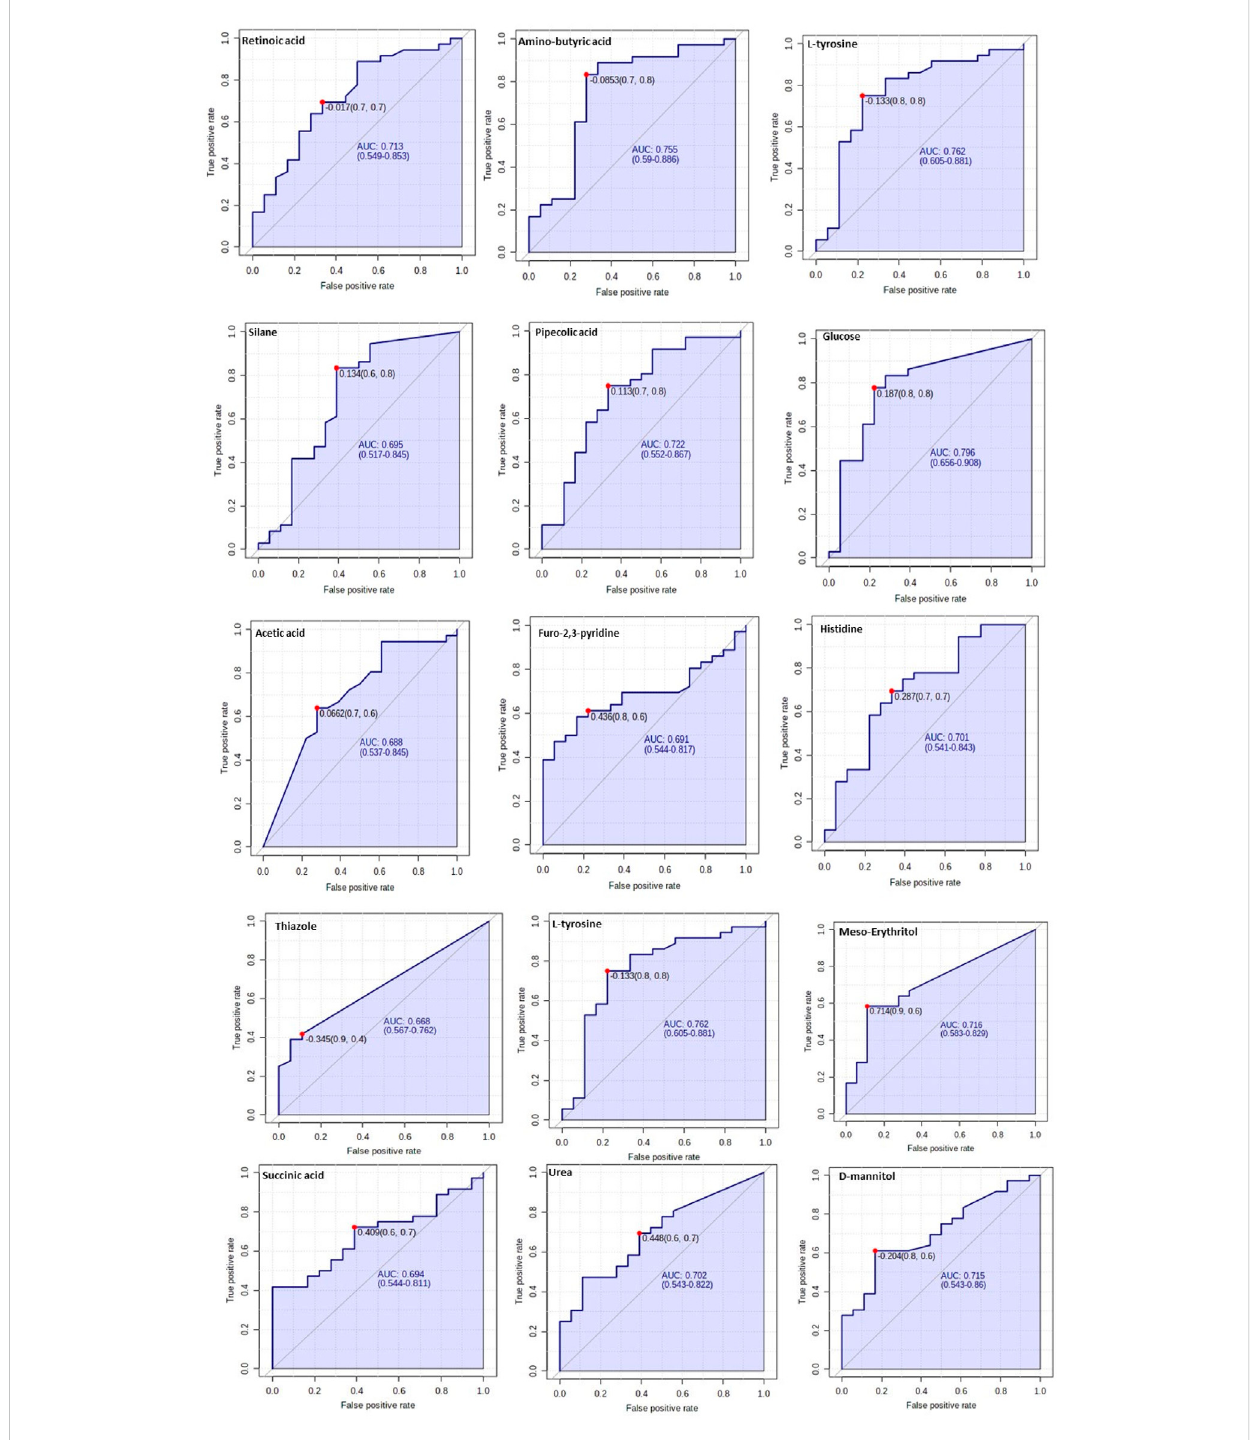
FIGURE 7 Veri fi cation of the top 15 identi fi ed potential biomarkers. ROC analysis to further depict the predictive value of these individual metabolites independently.